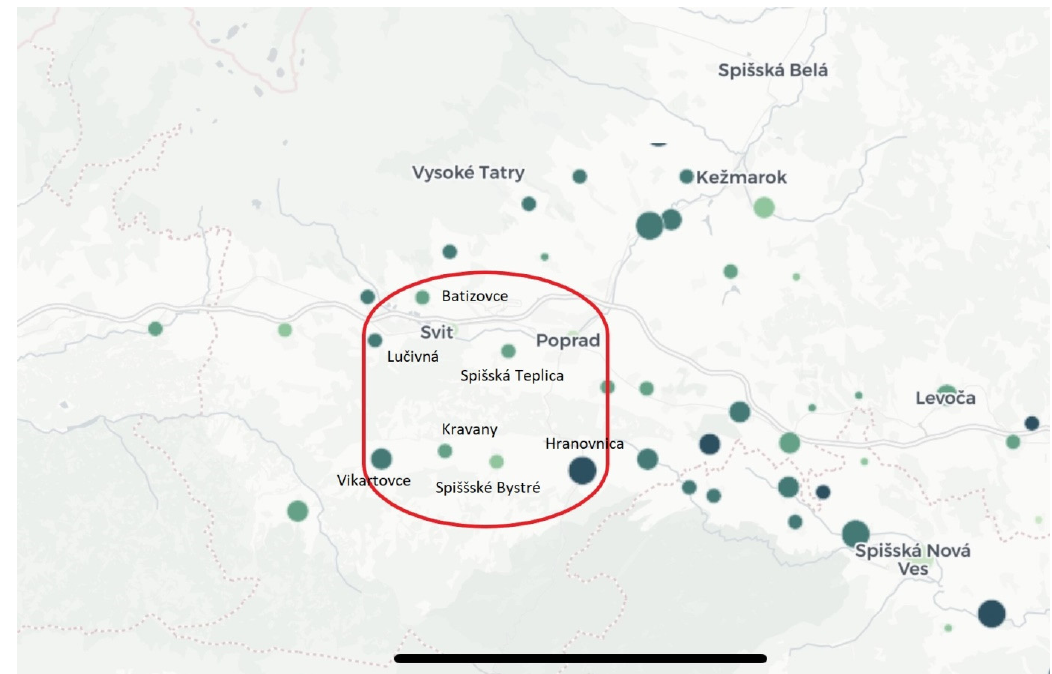
Figure 2. Where do Roma live? Slovakia, showing the district of Poprad (red circle). Source: Kerekes, 2019 [20] (green dots: the bigger the circle, the larger the number of Roma inhabitants, and darker colour indicates increased Roma population density) and the authors.